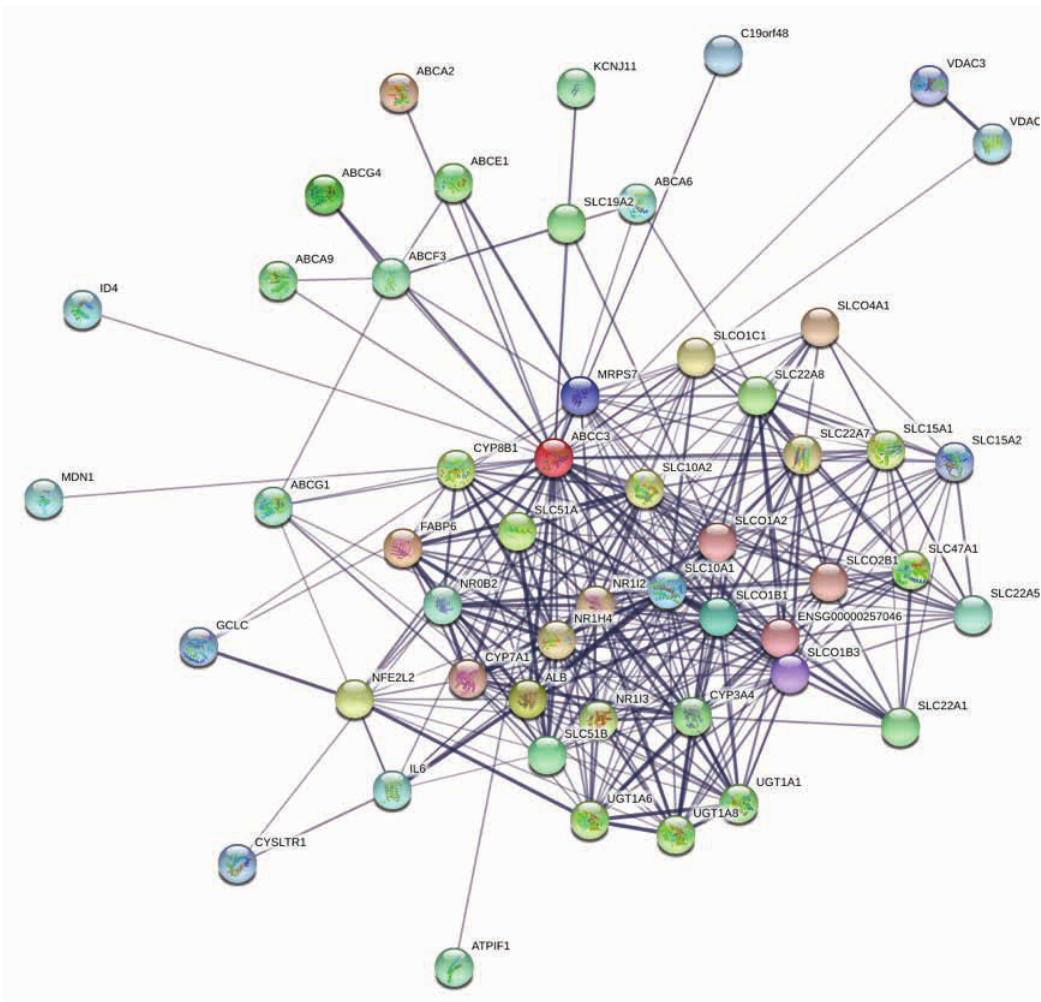
Figure 2: PPI Network for ABCC3 and related